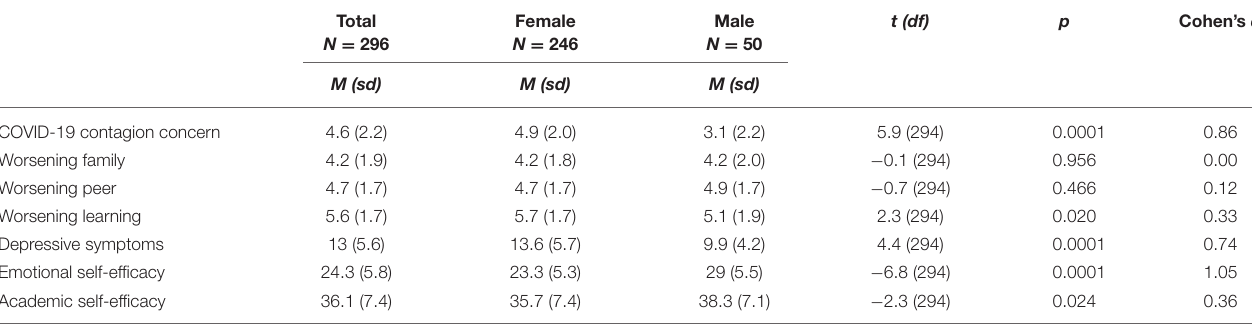
TABLE 4 | Descriptive statistics of study variables: means in the total sample and by gender.